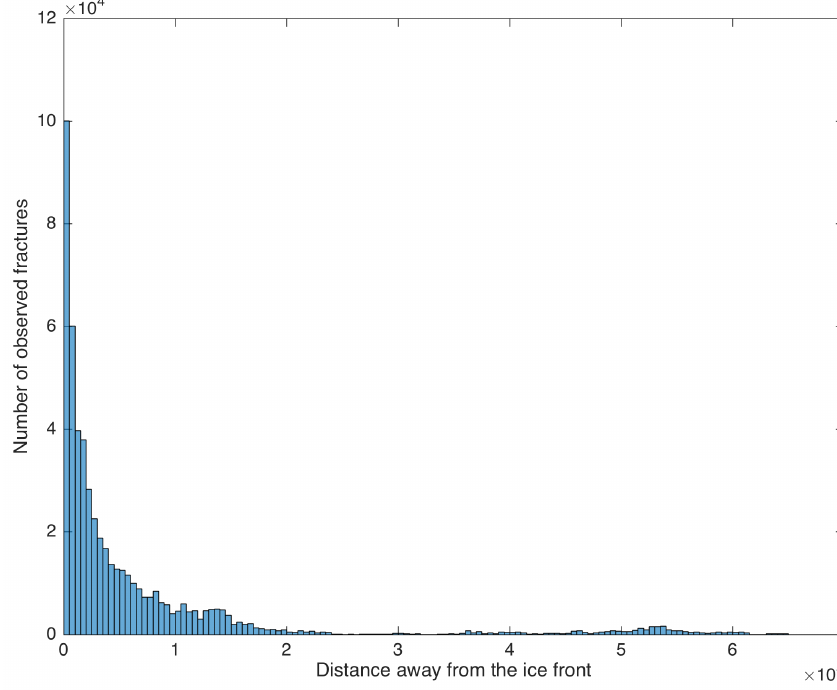
Figure 4. The number of observed fractures versus distance from the ice